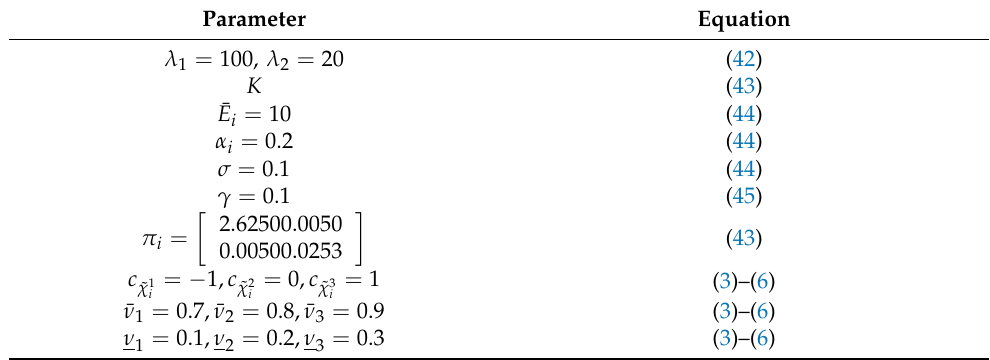
Table 1. Example 1: Simulation